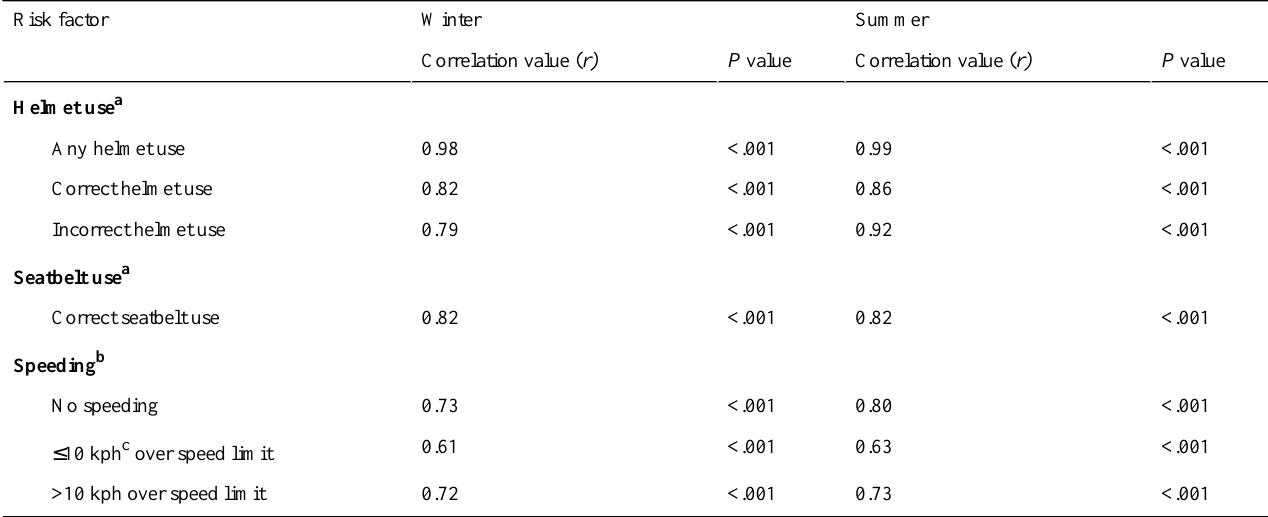
Table 3. Reliability in behavioral risk factor prevalence: Pearson correlation and P